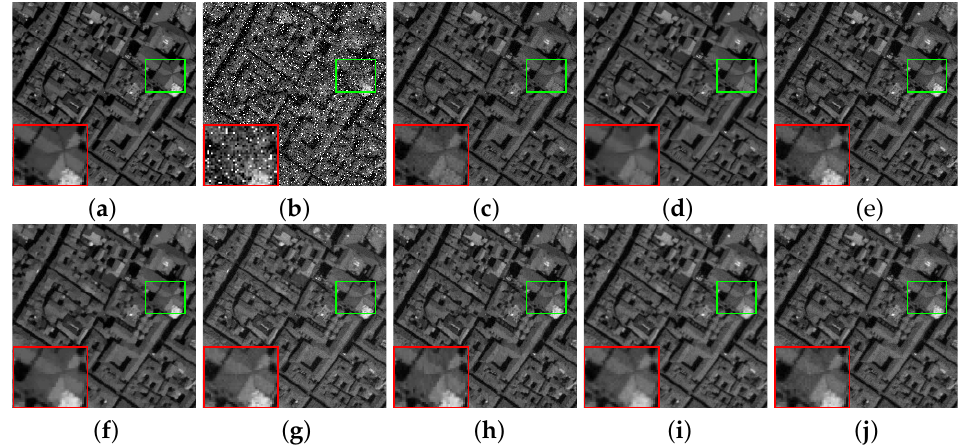
Figure 3. ( a ) Original image, ( b ) noisy image, image denoised by ( c ) LRTA, ( d ) BM4D, ( e ) LRMR,